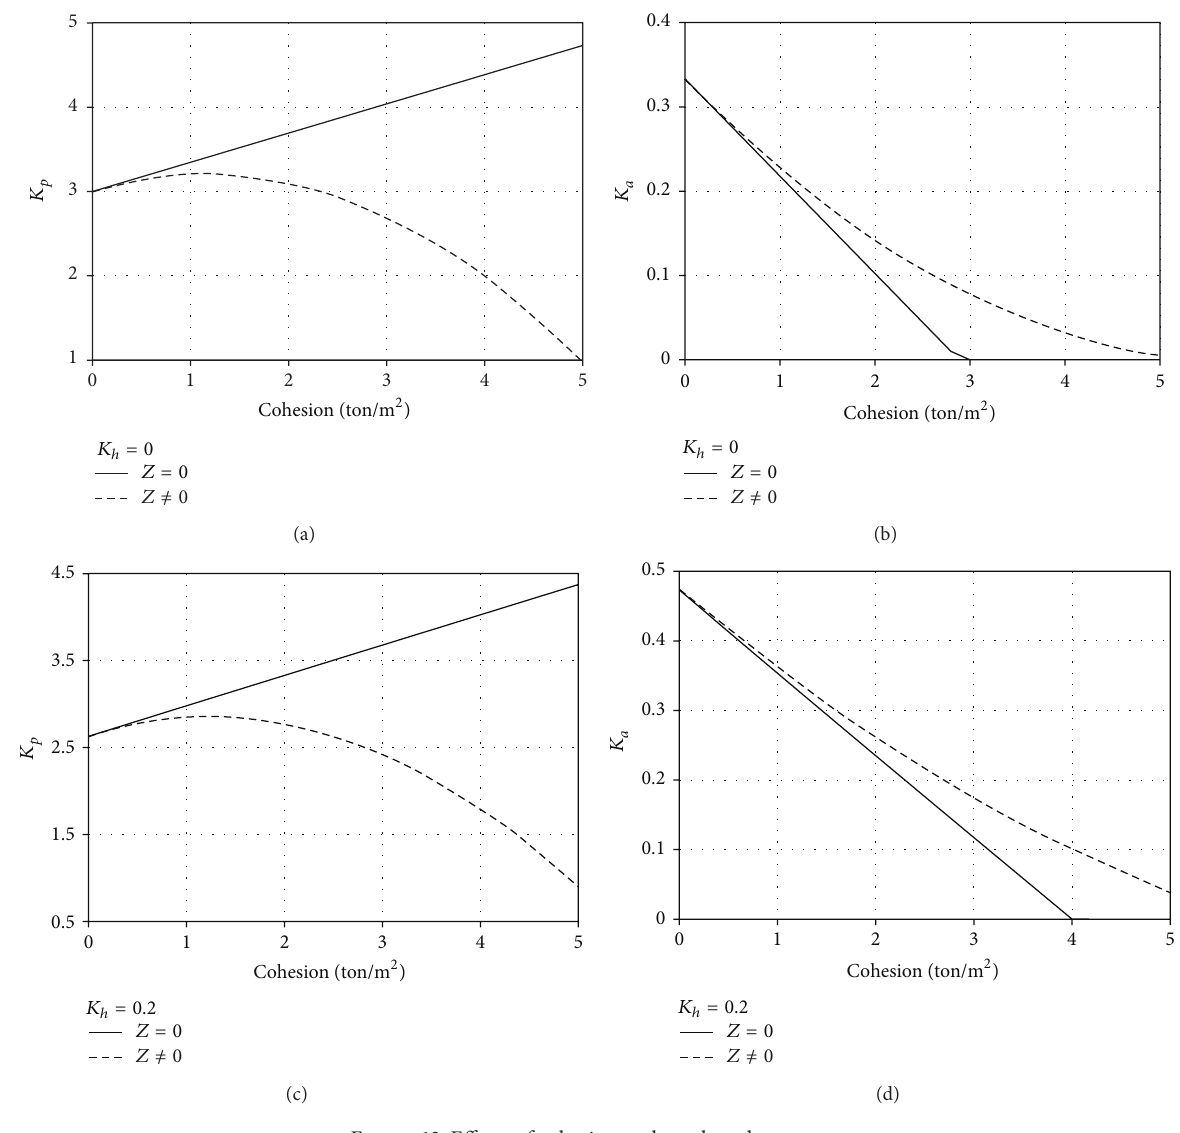
Figure 12: Effects of cohesion on lateral earth